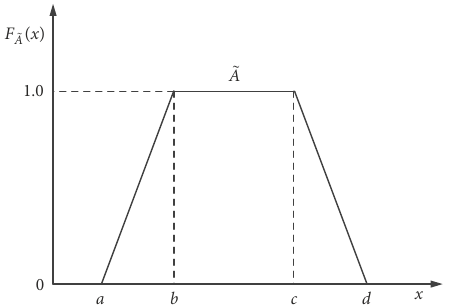
Figure 2. The normalized trapezoidal fuzzy number A a b c d ( , , , ) =